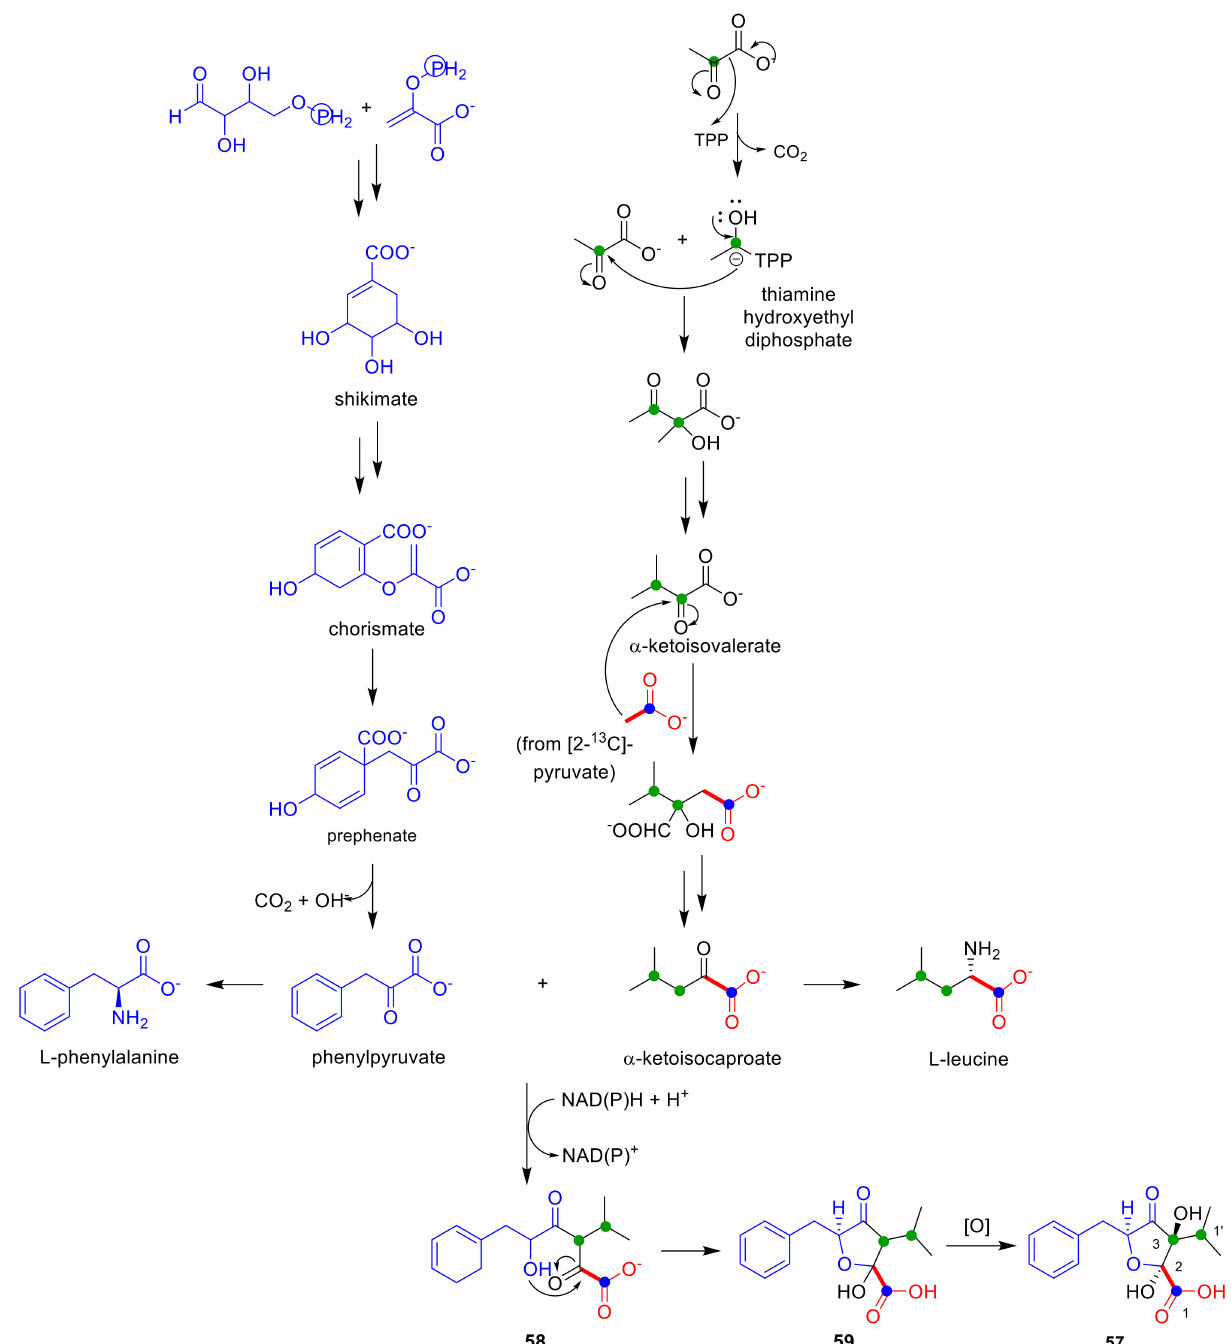
Figure 17. Proposed biosynthetic pathway to botrycinereic acid ( 57